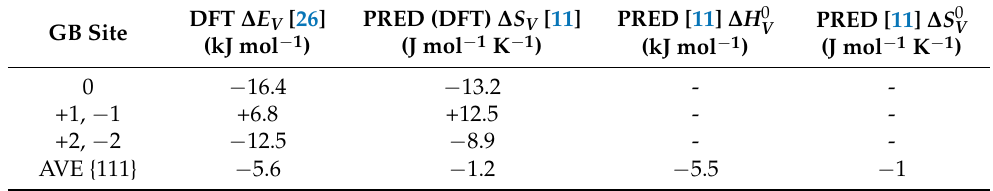
Table 2. The average values of ∆ H 0 and ∆ S 0 obtained on basis of prediction [11], and the values V V of ∆ E V , k calculated for individual sites [26], all corresponding to the {111} grain boundary of bcc Fe. Values of ∆ S V , k related to individual ∆ E V , k were estimated on basis of model [11] (Equation (4)). GB site, site according to [26]; PRED, prediction [11]; AVE, average; ∆ E V AVE, average of calculated segregation energies determined according to Equation (9) with ξ k = 1 and P = 5.